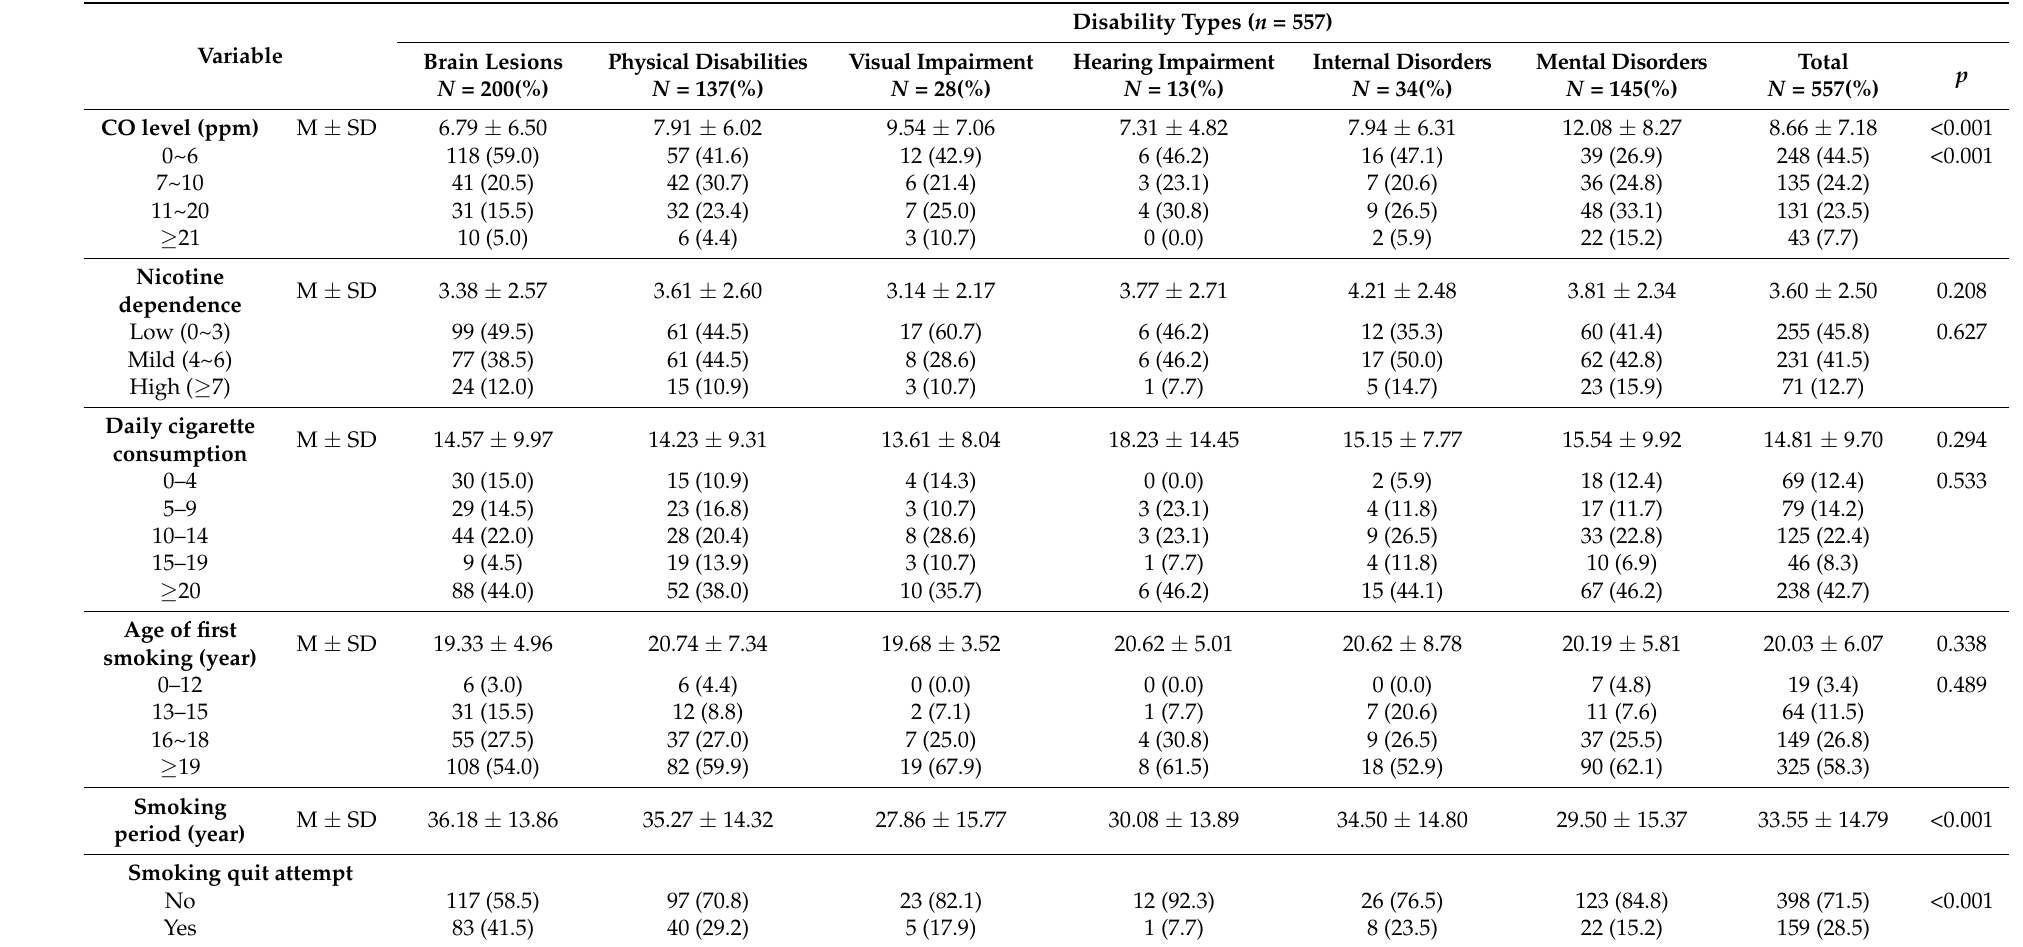
Table 2. Smoking-related characteristics according to disability